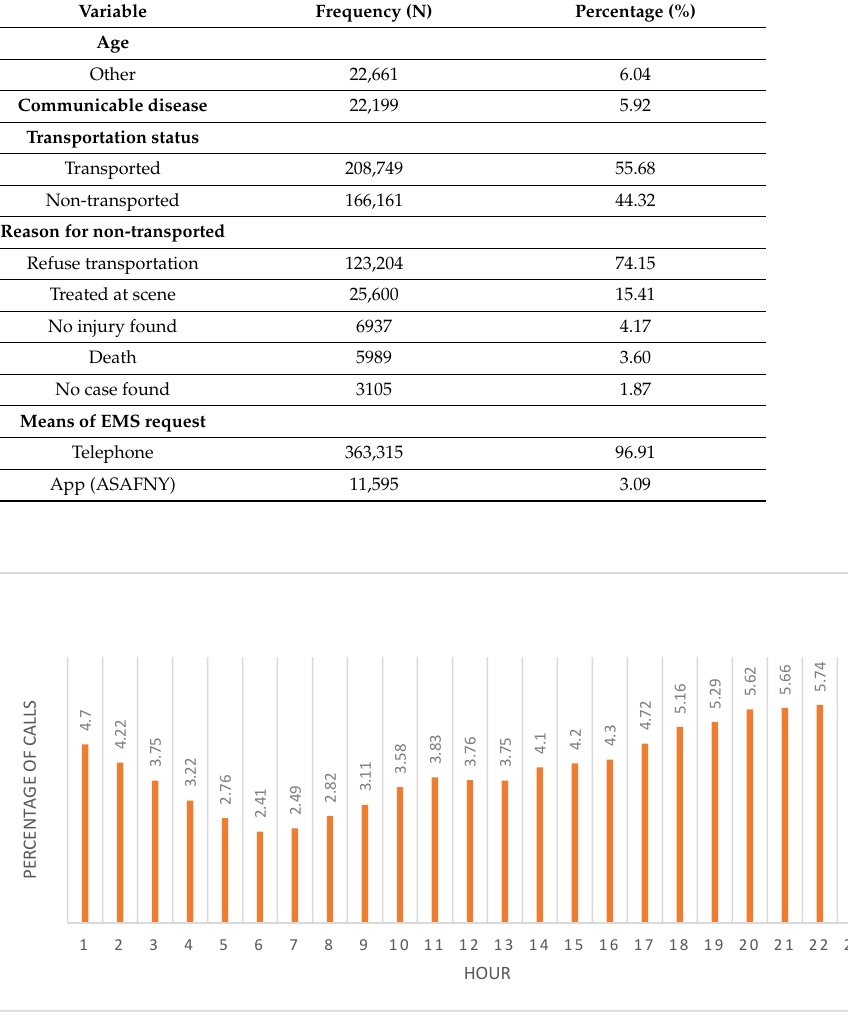
Figure 2. Percentage of emergency medical services (EMS) calls per hour of the day for the entire 5-month period. Day shift corresponded to 06:00 until 18:00; night shift to 18:00 until 06:00.